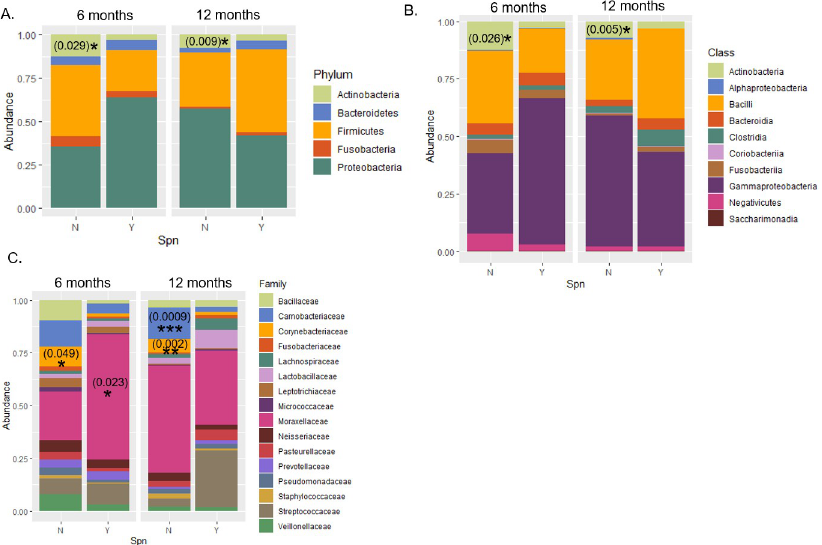
Fig 1. Abundance of taxa in Spn+ and Spn- NP samples. Proportion of taxa in Spn+ or Spn- NP samples at different ages were shown at the level of phylum (A), class (B), family (C) as bar plots. � : p < 0.05; �� : p < 0.005; ��� : p < 0.0005, Wilcoxon signed-rank test with Holm-Bonferroni adjustment. The absolute p values are included in parentheses on the graphs.